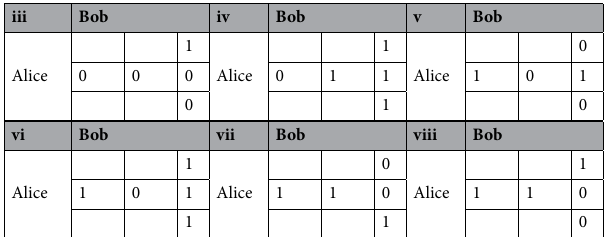
Table 2. Given a = 2 for Alice and b = 3 for Bob under ideal conditions, in addition to two possible winning instances given in Table 1, any of these six winning instances can occur each with probability 1/8 by applying B A 3 and performing the 2 and